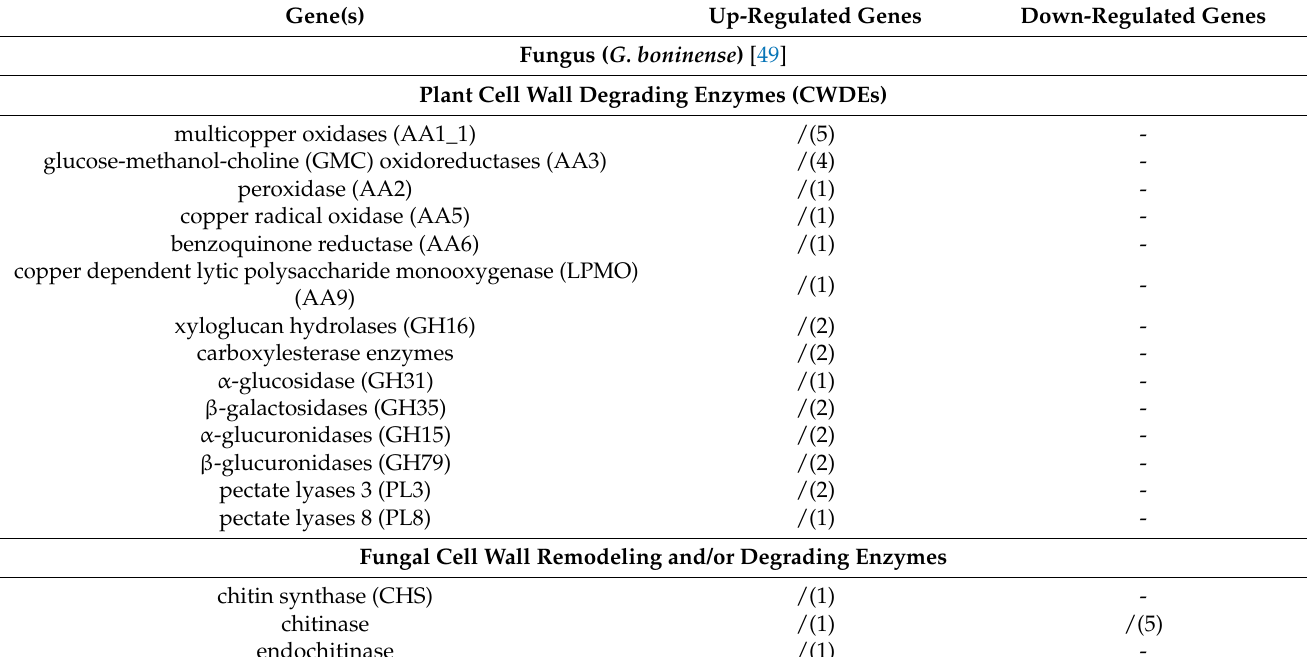
Table 2. List of up-regulated and down-regulated genes between G. boninense and the plant host seedlings, E. guineensis . Gene(s) Up-Regulated Genes Fungus ( G. boninense )